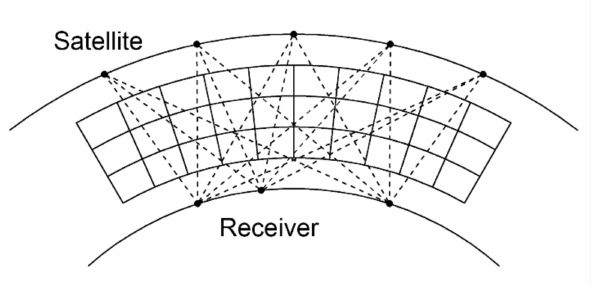
Figure 2. Diagram of the three-dimensional ionosphere. The ionosphere is divided into discretized three-dimensional voxels. The voxels are traversed by plenty of satellite-receiver rays and the ionospheric electron density (IED) of the illuminated voxels can be